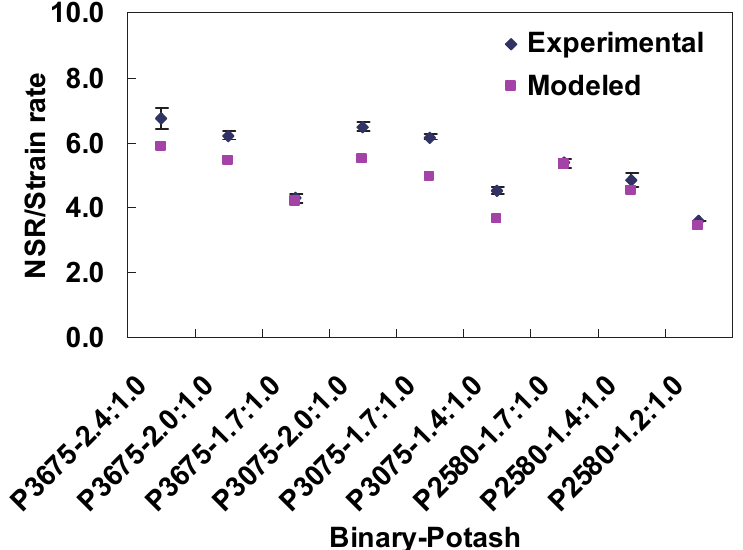
Fig. 5 Validation of dimensional analysis model by comparison of modeled values to experimental values for potash at strain rate of 0.5Hz, with ± SD as error bars (P-potash, first four number after P is mean size of coarse particles followed by binary size ratio corresponding to coarse mean